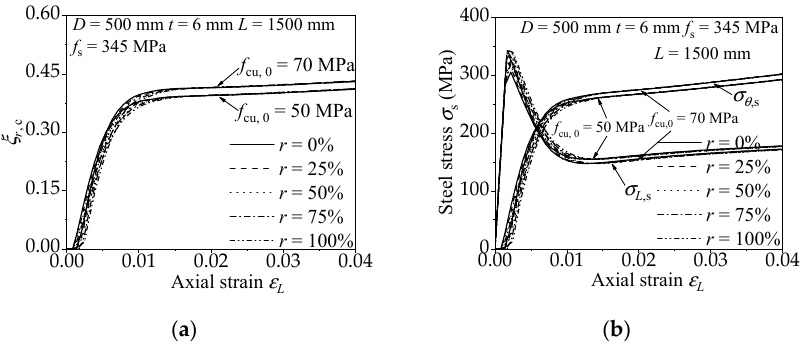
Figure 7. Effect of concrete strength on confinement effect of RACFCST stub columns: ( a ) radial stress–axial strain curves; ( b ) ξ r, c –axial strain curves; ( c ) steel stress–axial strain curves.